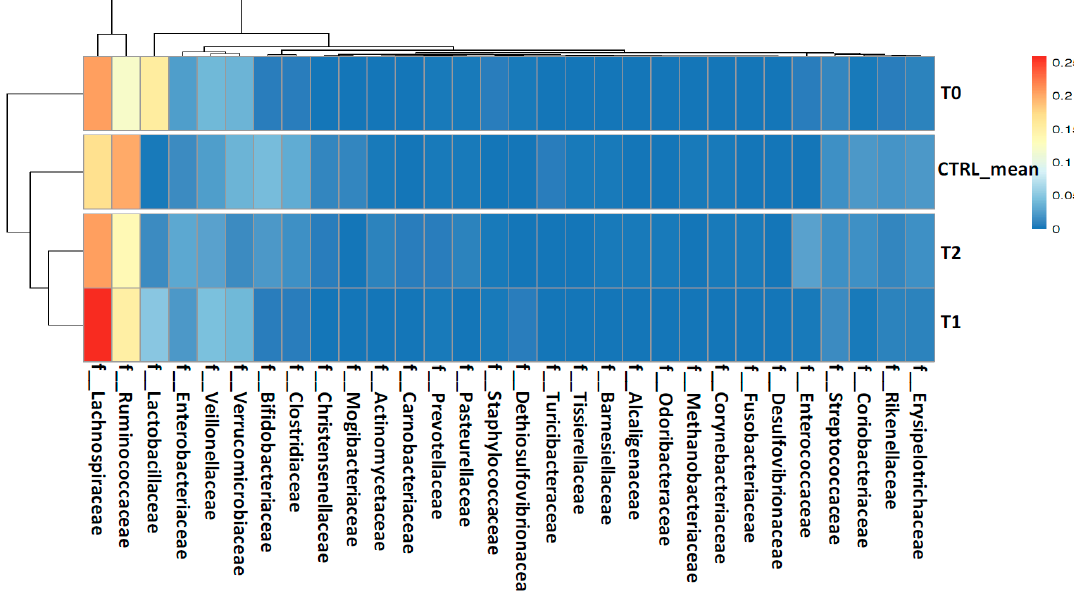
Figure 5. Heatmap with hierarchical clustering based on genera (L6) abundances. The colors in the heatmap refer to the genus abundance, according to the color scale on the right. The gut microbiota biodiversity between the three patient’s time-point samples and CTRLs was also analyzed via beta-diversity. According to the previous results highlighted by hierarchical clustering, this analysis revealed a shaping of the patient’s gut microbiota during (T 0 ) and after (T 1 and T 2 ) nematode infection, with the T 1 sample close to the T 0 and the T 2 sample shifted to the controls (Figure 6).